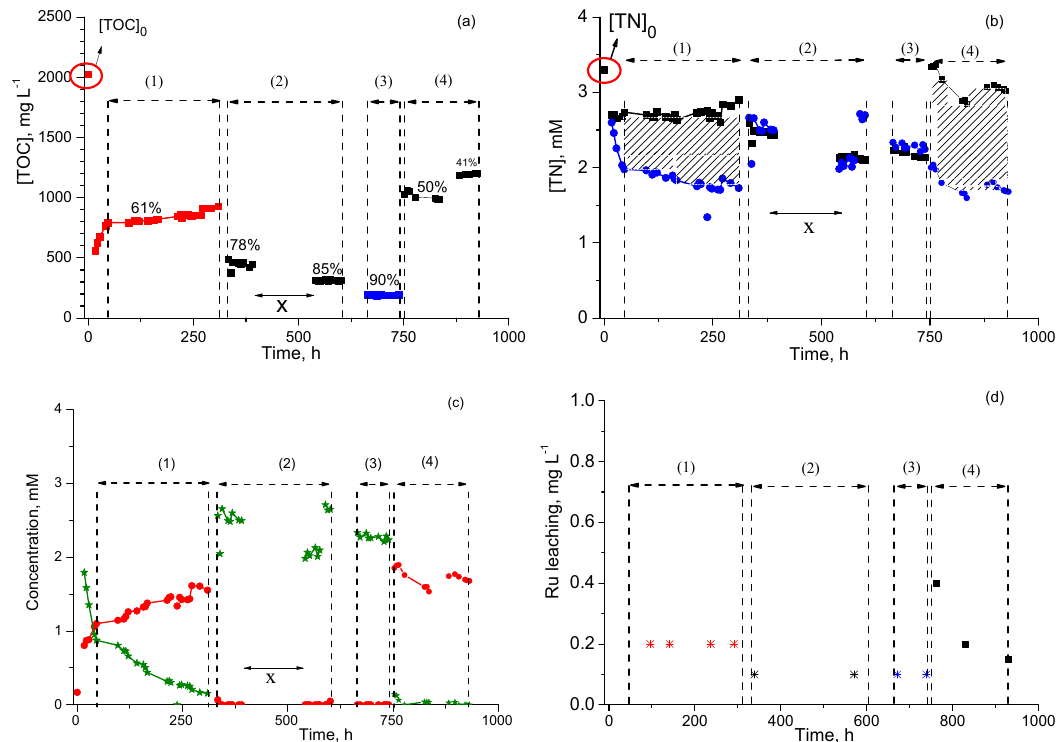
Figure 12. Oxidation of sugarcane vinasse in the continuous reactor over the Ru/TiO 2 -G catalyst. ( a ) Figure 2. Evolution of: ( a ) Total Organic Carbon (TOC) and ( b ) concentrations of Total Nitrogen (TN) TOC, ( b ) total nitrogen ( ■ measured with a TN meter, and ● calculated from ionic chromatography), ( a ) TOC, ( b ) total nitrogen ( (cid:4) measured with a TN meter, and (cid:8) calculated from ionic chromatography), (measured by TOC-TN apparatus) and different N-species (analyzed by ionic chromatography) ( c ) different N-species ( • , ammonium;  , nitrate) and ( d ) the leaching of Ru during these different ( c ) di ff erent N-species ( (cid:8) , ammonium; during oxidation of diluted VBC in the absence of a catalyst: TN ( ■ ), NH 4+ ( • ), NO 3- (  ), and NO 2- ( 7 ). periods with contact times (tcs) of (1) 0.99 h g cata g TOC-1 , (2) 1.98 h g cata g TOC-1 , (3) 2.97 h g cata g TOC-1 , and At time zero, after introduction of air at the reaction temperature, TOC concentration was, as expected, around 1500 mg L –1 (Figure 2a). Some organic compounds in VBC were then mineralized to attain 60% TOC conversion after 7 h at 190 °C. Figure 2b details the concentrations of the different nitrogen species during oxidation at 190